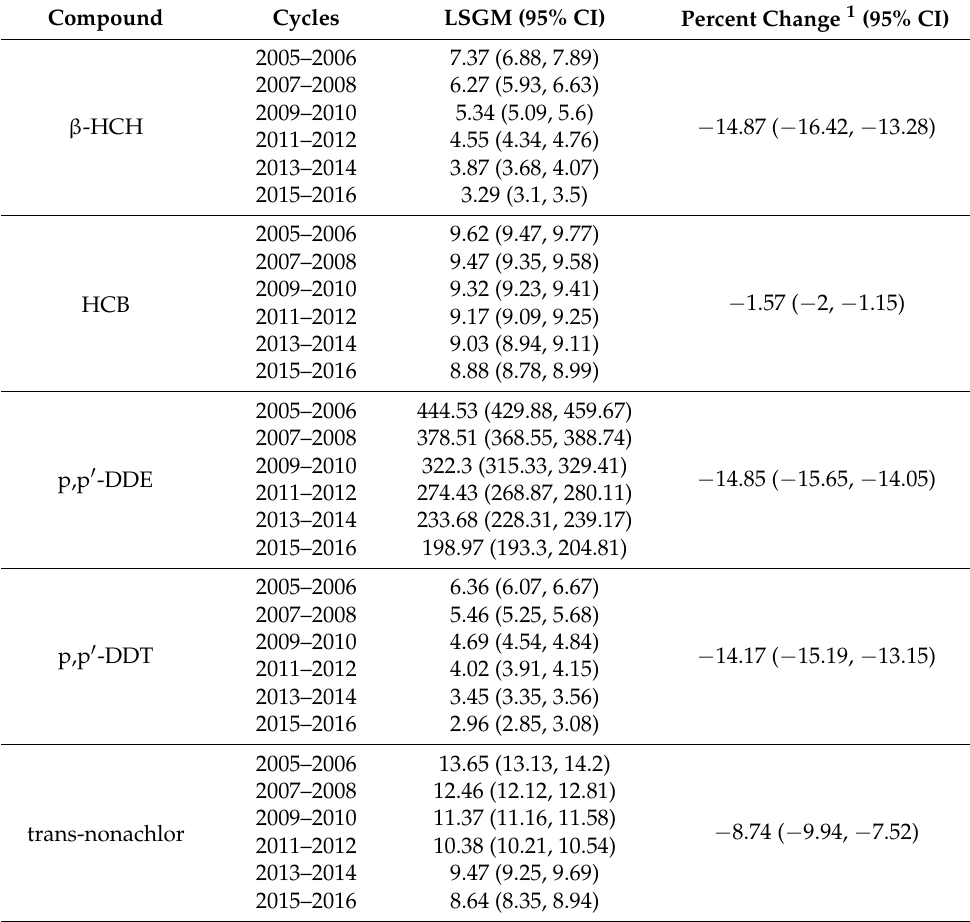
Table 2. LSGM (ng/g Lipid) by Survey Cycles and Percent Change by the 2-Year Survey Cycle for